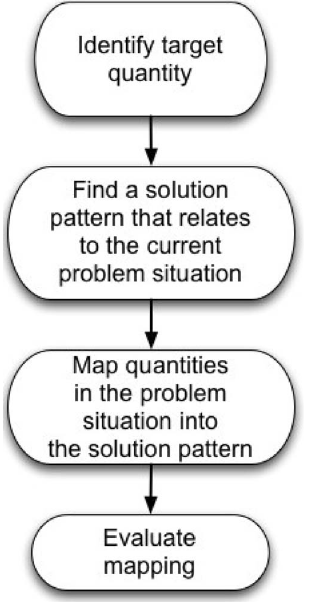
FIG. 6. Schematic diagram of some moves in the epistemic game Transliteration to